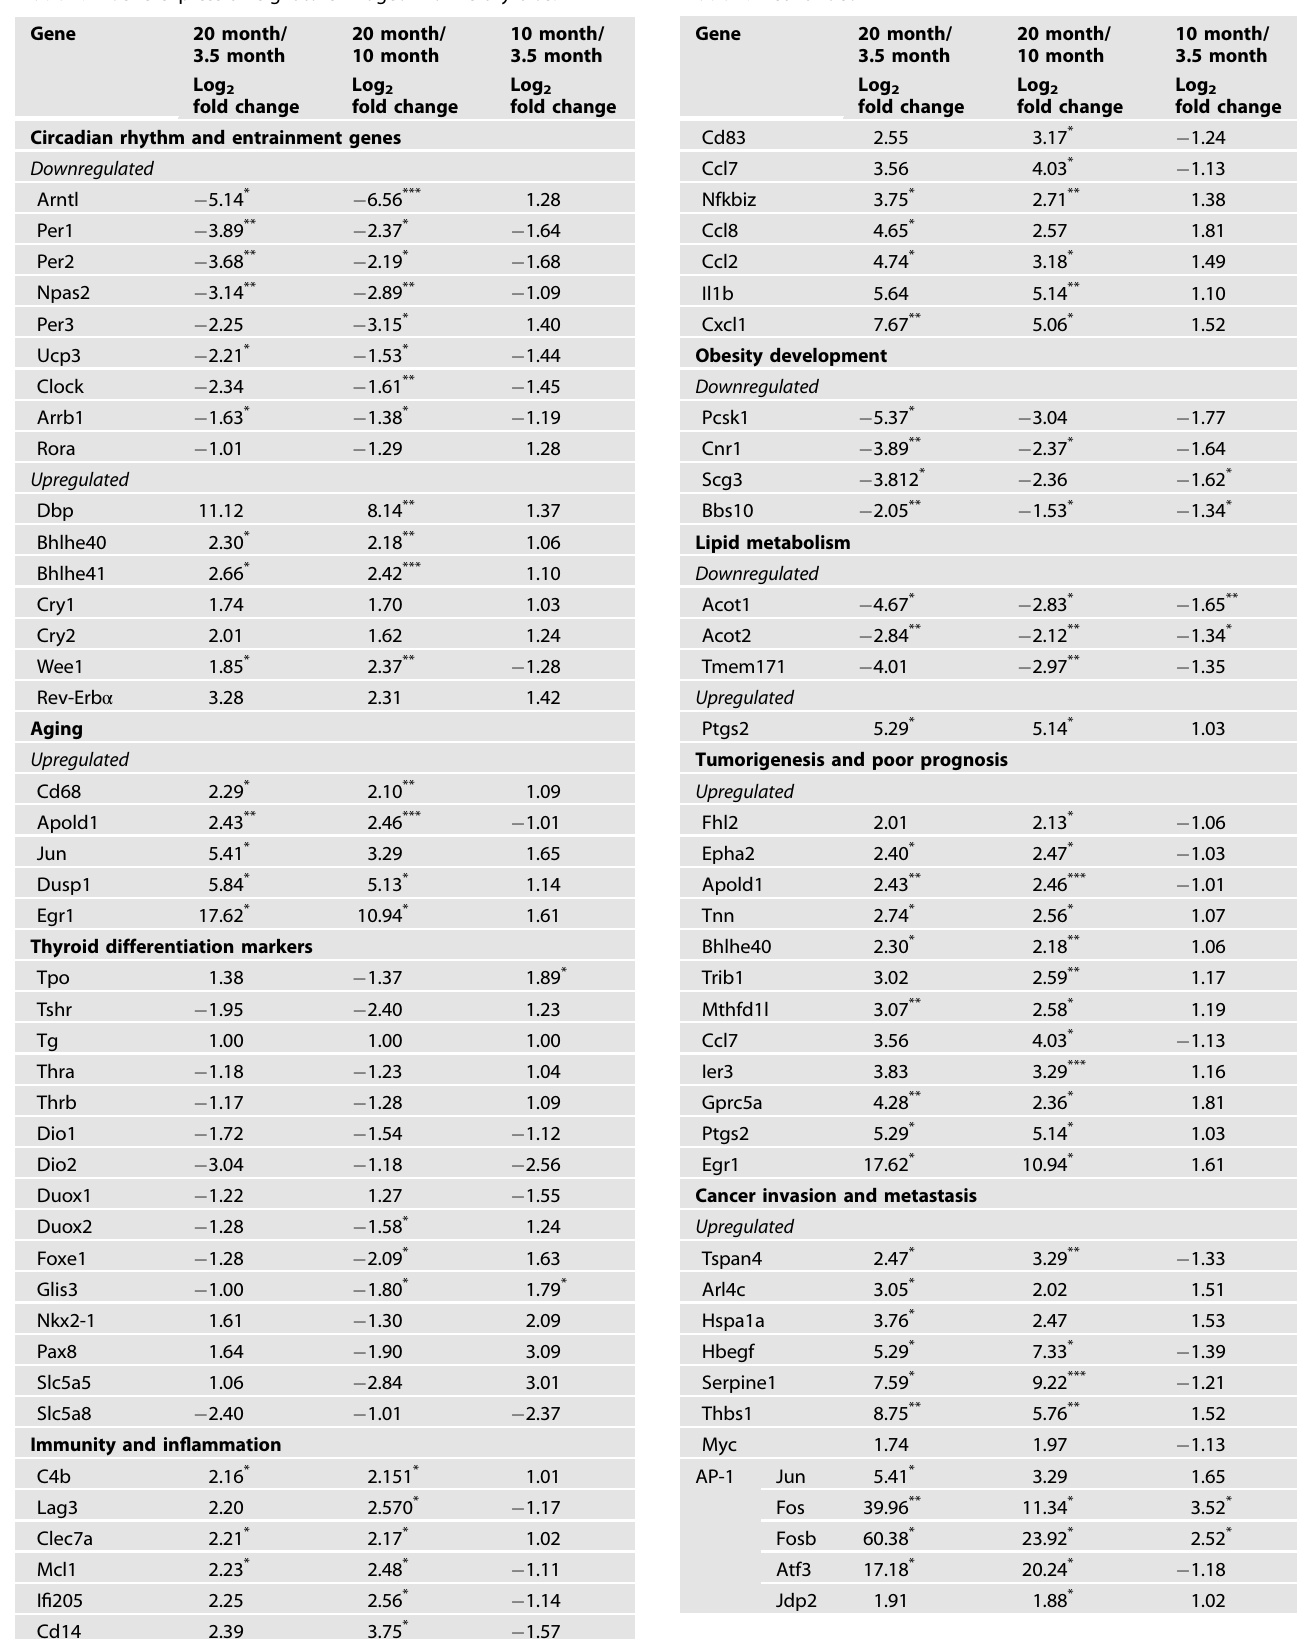
Table 1. Gene expression signature in aged murine